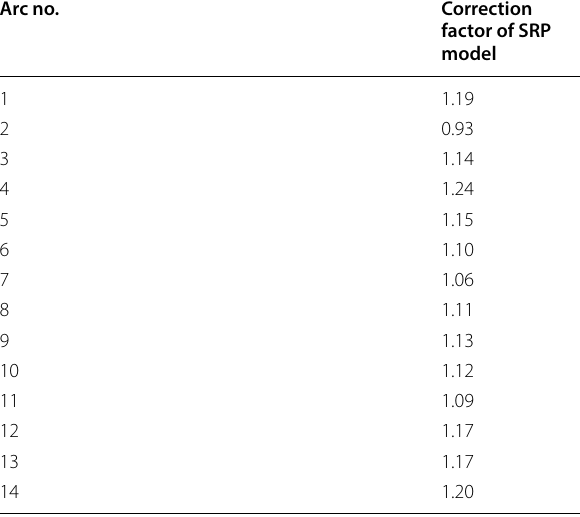
Table 2 Correction factor of the solar radiation pressure (SRP) model with respect to our initial SRP model for each of the 14 arcs estimated by fixing GM of Ryugu to 29.8 m/ s 2 Arc